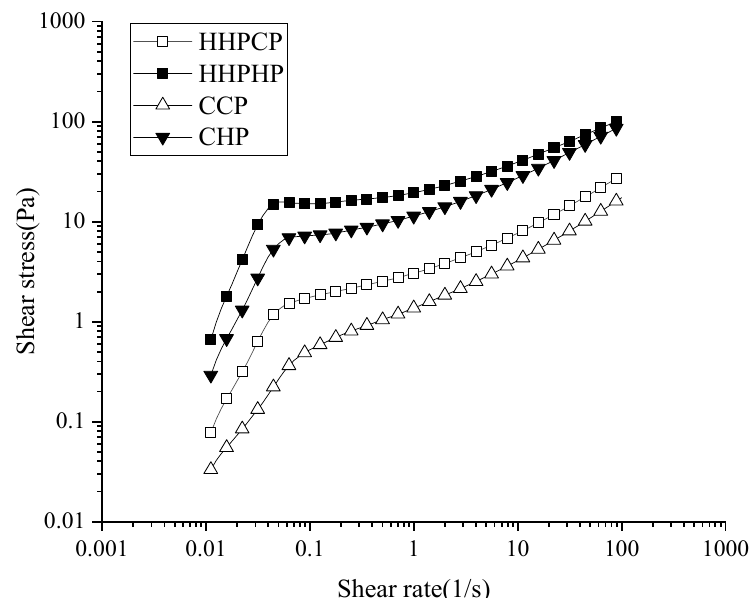
Figure 5. Rheological properties of solutions prepared from pectin extracted by different methods.